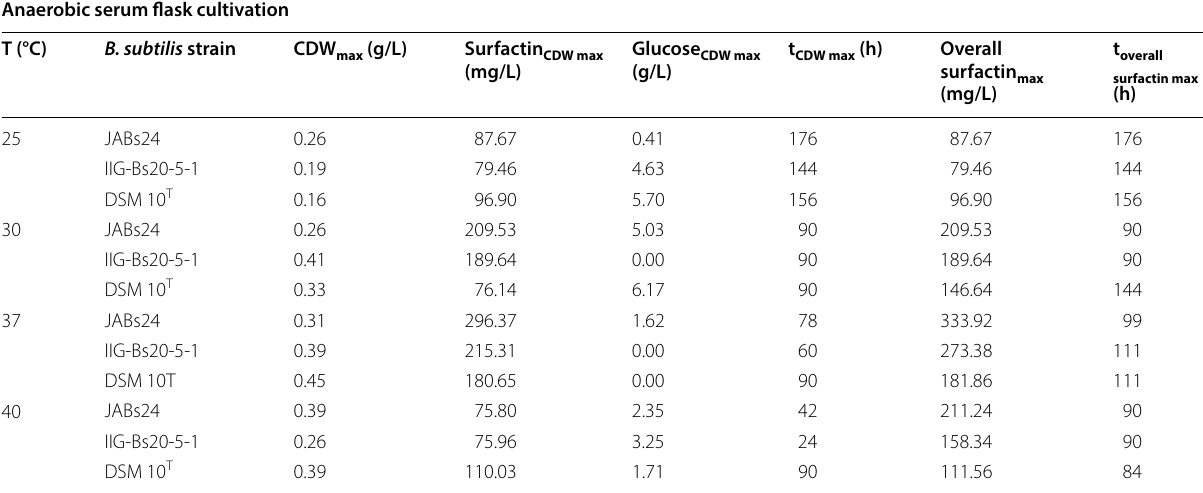
Table 3 Summary of the results obtained for anaerobic cultivations at various temperatures Anaerobic serum flask cultivation T